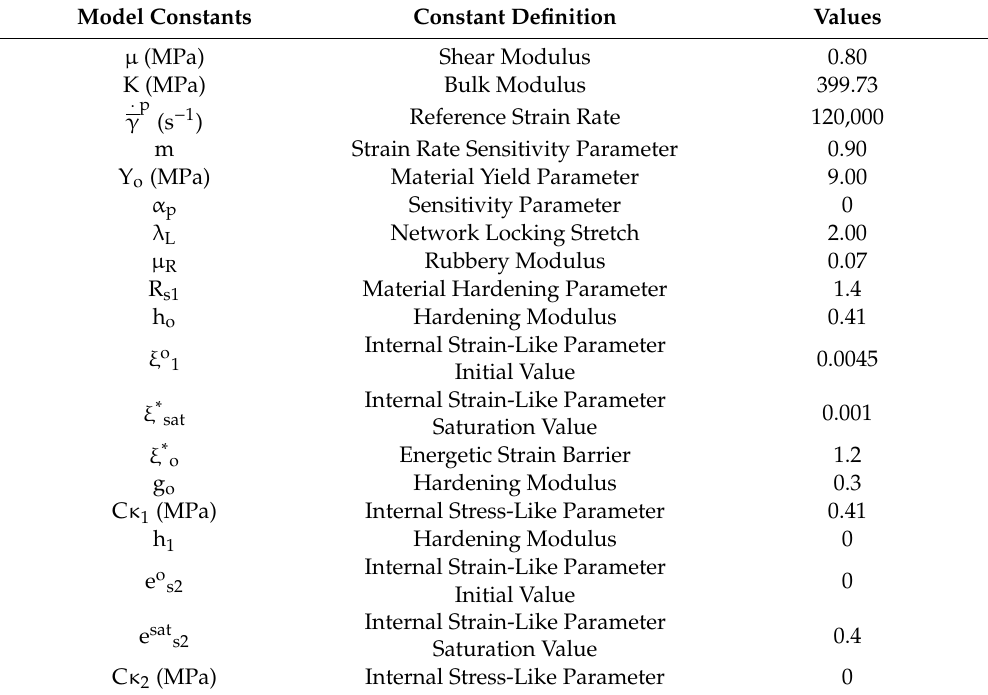
Table 4. Values of material constants for dry brain material using MSU TP Ver. 1.1 viscoplasticity model along with their